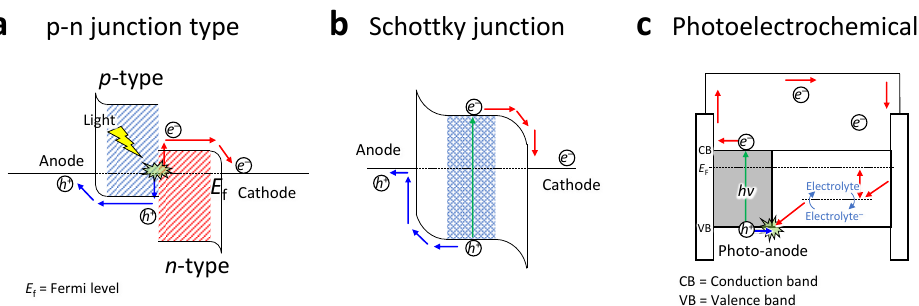
Figure 1. Self-powered photodetector/photovoltaic mechanisms: ( a ) the p-n junction type, ( b ) the Schottky junction type, and ( c ) the photoelectrochemical type.